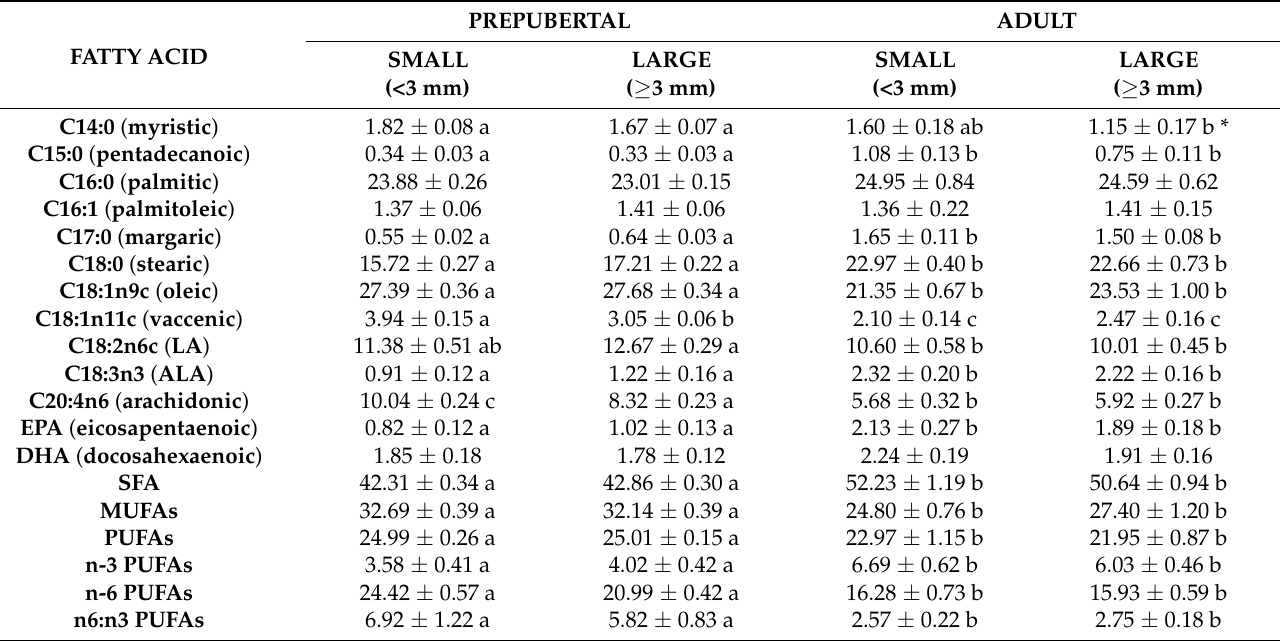
Table 1. Percentage of Fatty Acid composition of follicular fluid according to age of the donor and follicle size.